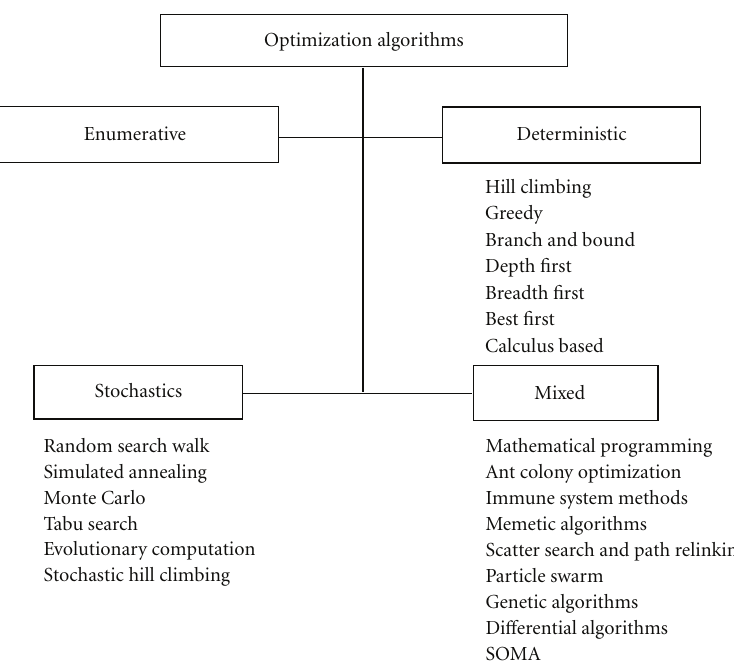
Figure 2: Division of evolutionary algorithms, taken from